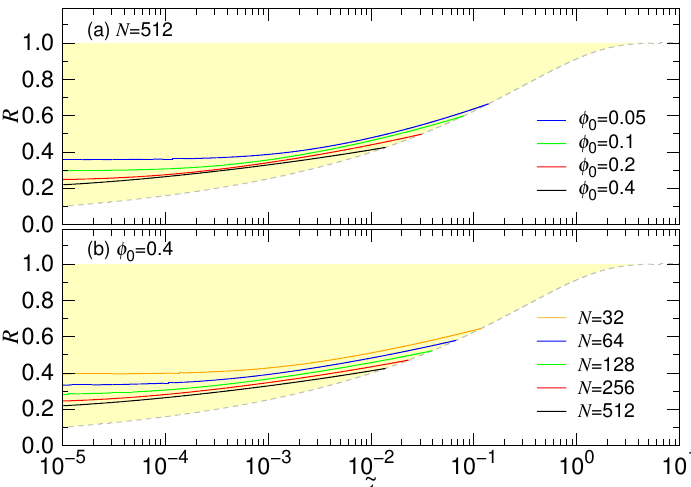
Figure 20. Prediction of chain size plotted by using the scaled time ˜ t and length variable ˜ R . The size (cid:17) α (cid:16) variation in the first stage, ˜ R ( ˜ t ) = ˜ R 0 1 + ˜ t , are plotted in colored lines ( a ) at N = 512 for various ˜ τ s φ 0 values and ( b ) at φ 0 = 0.4 for various chain lengths. The color representations are given in the legend of each panel. The principal variation curve for the second stage, ˜ R ( ˜ t ) = ( 1 − exp ( − ˜ t )) 1/5 , is plotted in gray dashed line. The yellow region denotes the domain space where situate the size variation curves for the first